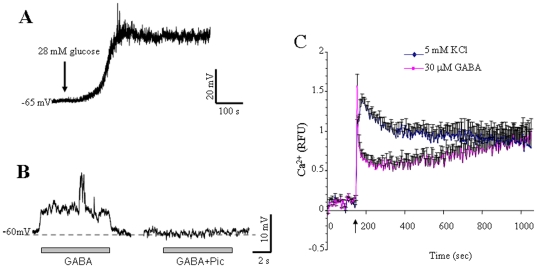
GABA depolarizes membrane potential and increases intracellular Ca2+ in INS-1 cells.(A) Perfusion of ECS containing 28 mM glucose induces a gradual and sustained depolarization of the membrane potential (Vm) (n = 5). (B) GABA induces a rapid and GABAAR inhibition-sensitive depolarization of Vm under the current-clamp conditions at 1.4 mM glucose (n = 5). (C) Cells cultured in 96-well plates pre-loaded with Fluo-3 AM were treated with GABA (30 µM), or 5 mM KCl as positive control. Changes in relative fluorescence units (RFU) were monitored with a fluorescent plate reader. Data are Mean±SE, n = 6.